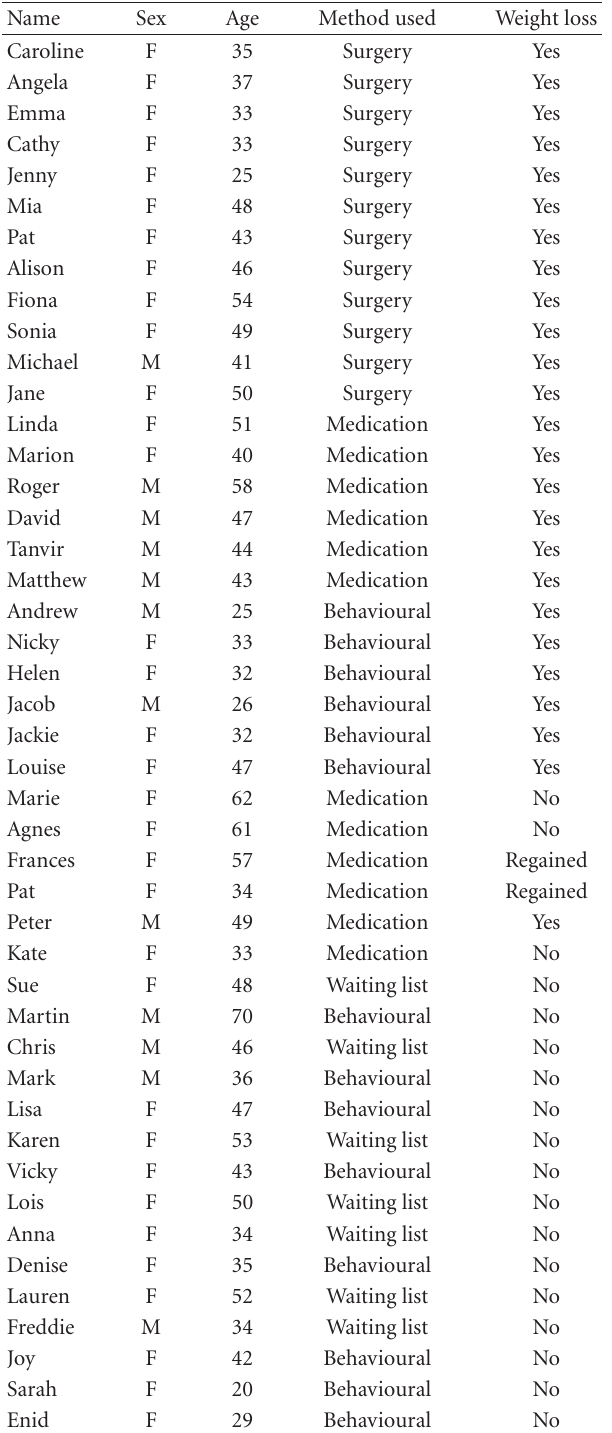
Table 1: Participants’